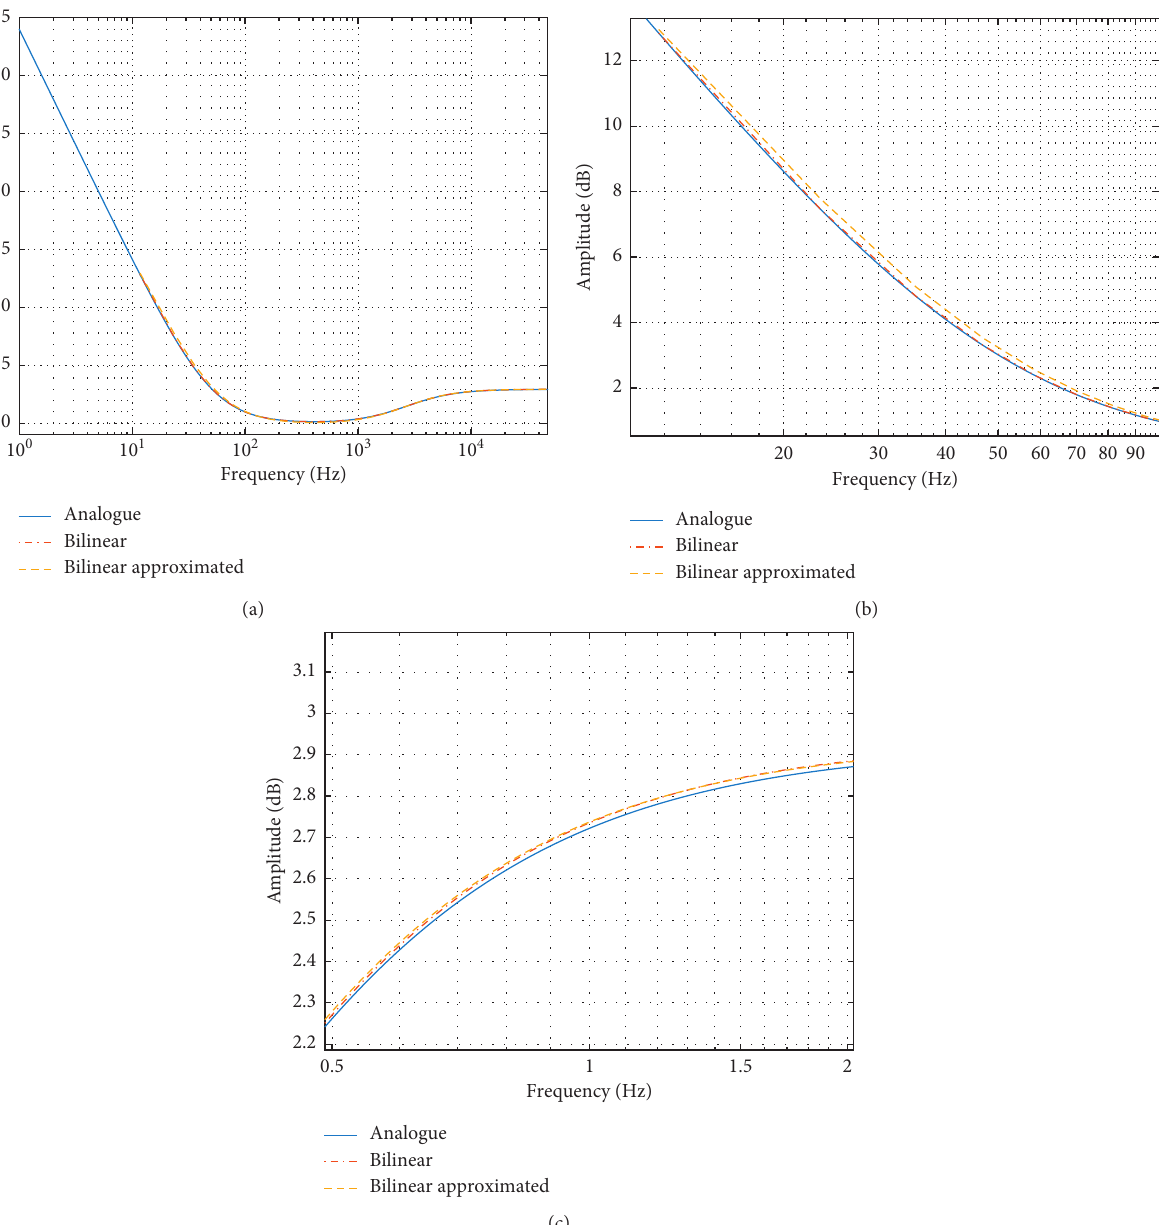
Figure 2: (a) A comparison between the frequency response of the analog unstable filter (“analogue”), the digitized unstable filter (“bilinear”), and the approximated stable filter (“bilinear approximated”). (b, c) Approximation quantification in further detail, specifically focusing on low and high frequencies, respectively. (a) Overall comparison. (b) Low-frequency approximation. (c) High-frequency